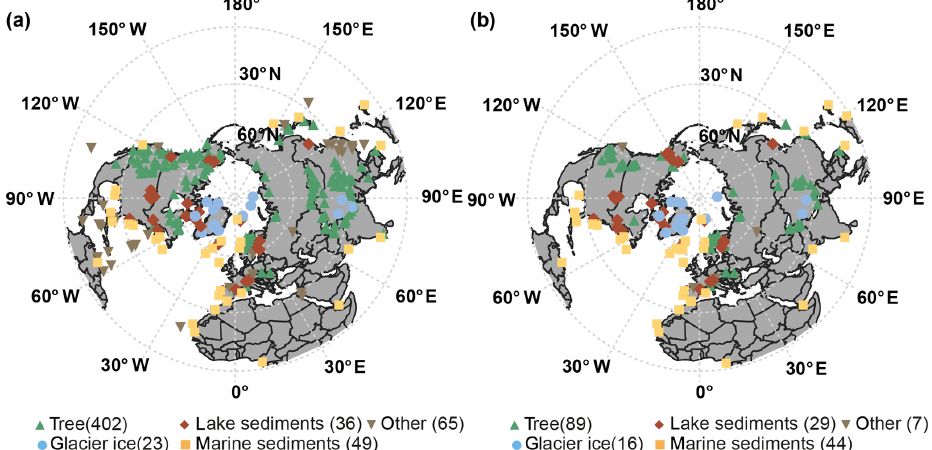
Figure 1. (a) Map showing the spatial distribution of Northern Hemisphere proxy records from the PAGES2k 2.0.0 database including primary tree-ring (green), glacier ice (blue), marine (orange) and lake (red) sediment records as well as a smaller number of records from bivalves, boreholes, corals, documents, hybrids, sclerosponges, and speleothems (brown). Panel (b) same as (a) but showing only those records longer than 800